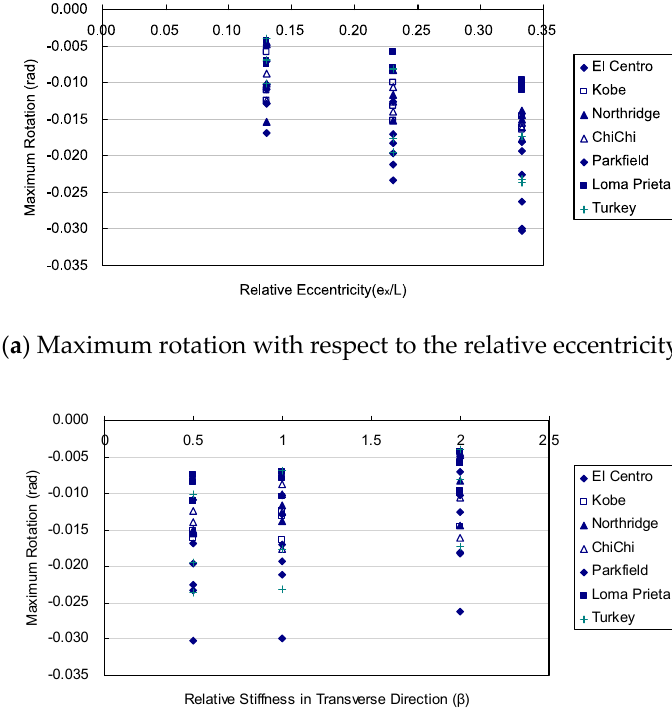
( b ) Maximum rotation with respect to the relative stiffness in the transverse direction. Figure 17. Effects of the relative eccentricity and relative stiffness in the transverse direction on the Figure 17. E ff ects of the relative eccentricity and relative sti ff ness in the transverse direction on the maximum rotations obtained by the time history analysis simulations. maximum rotations obtained by the time history analysis simulations. Table 4. Results of the time history analysis, the proposed method and the linear elastic response. (El Centro). Time History